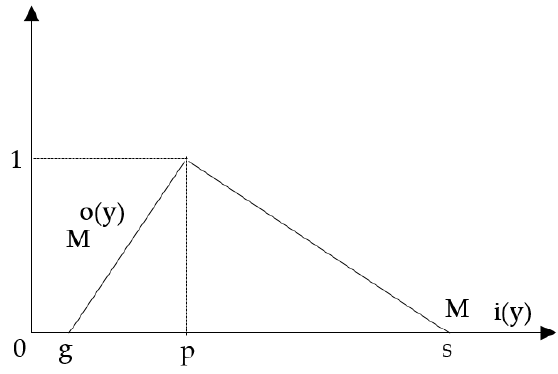
Figure 4. Traingular fuzzy number.